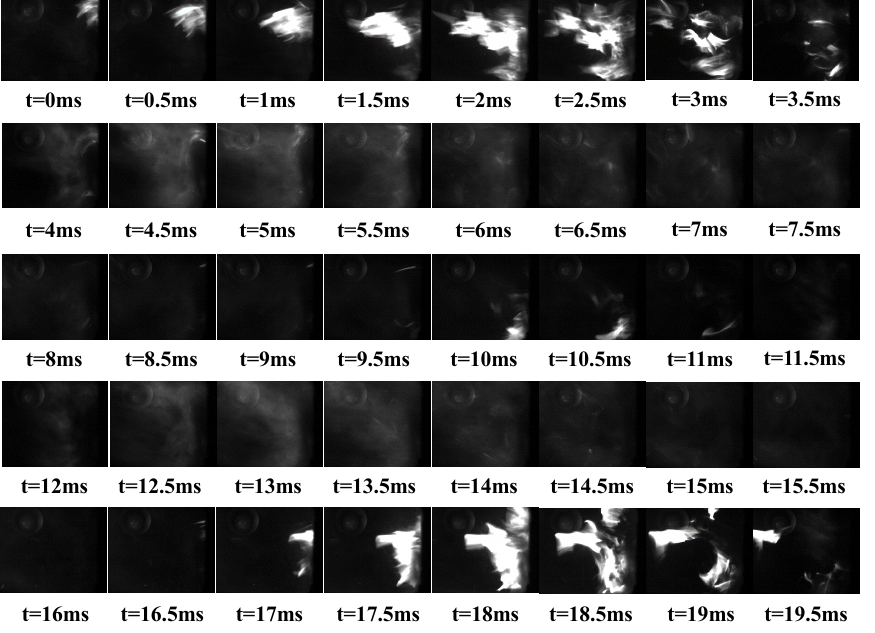
Figure 25. Flame change images of the L combustor.